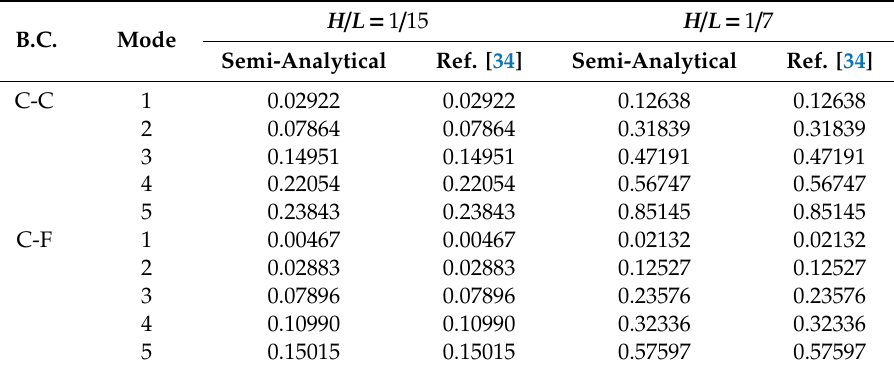
Table 2. Non-dimensional frequencies Ω for C-C and C-F FGM straight beams ( α = 1).